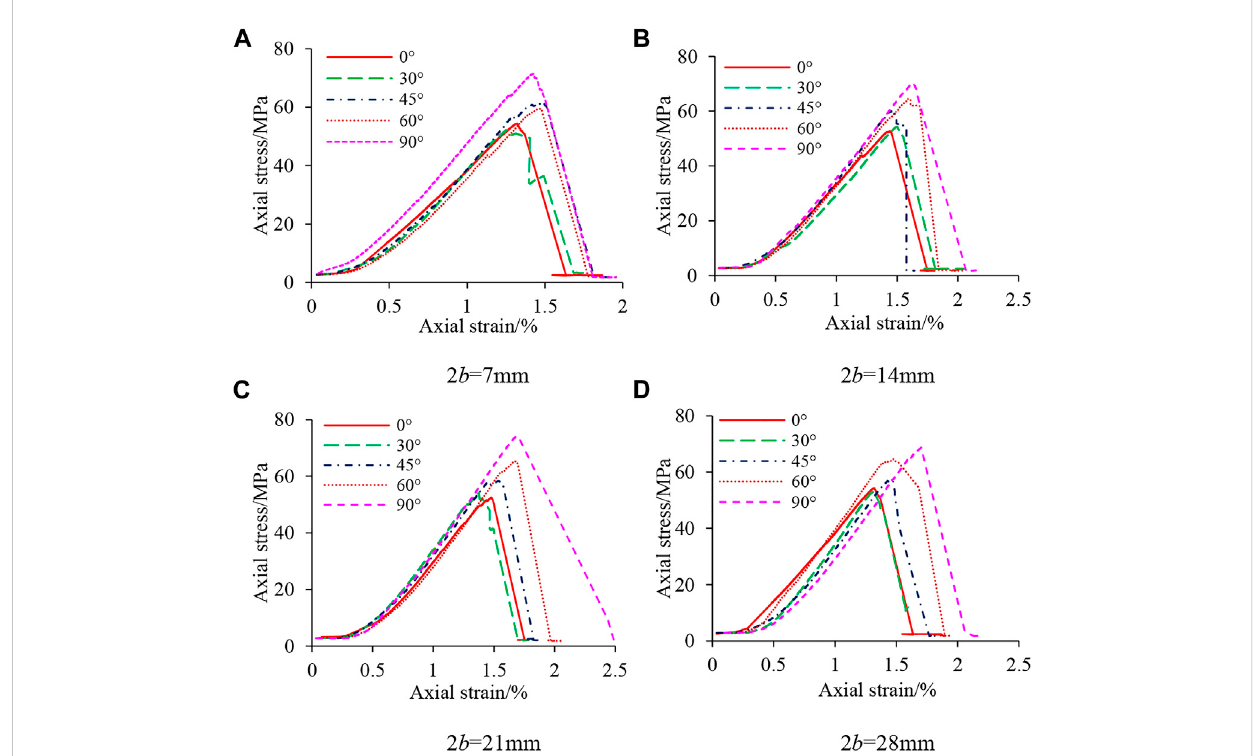
FIGURE 5 Axial stress-strain curve of rock specimens with different fi ssured angles. (A) 2 b = 7 mm; (B) 2 b = 14 mm; (C) 2 b = 21 mm; (D) 2 b = 28 mm.